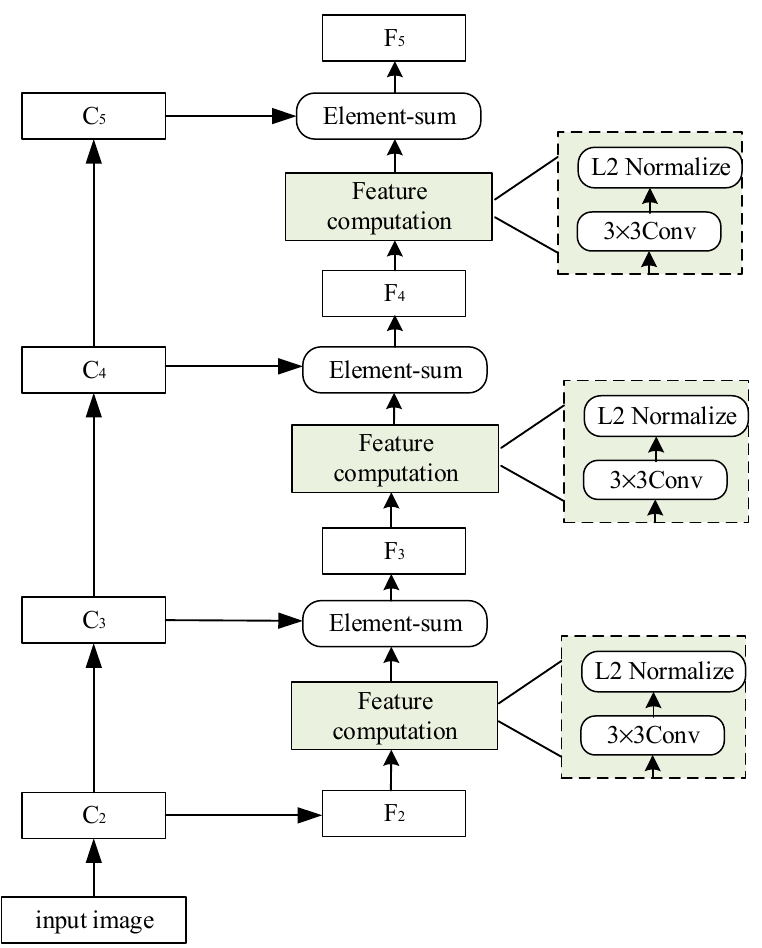
Figure 2. Architecture of feature fusion branch.